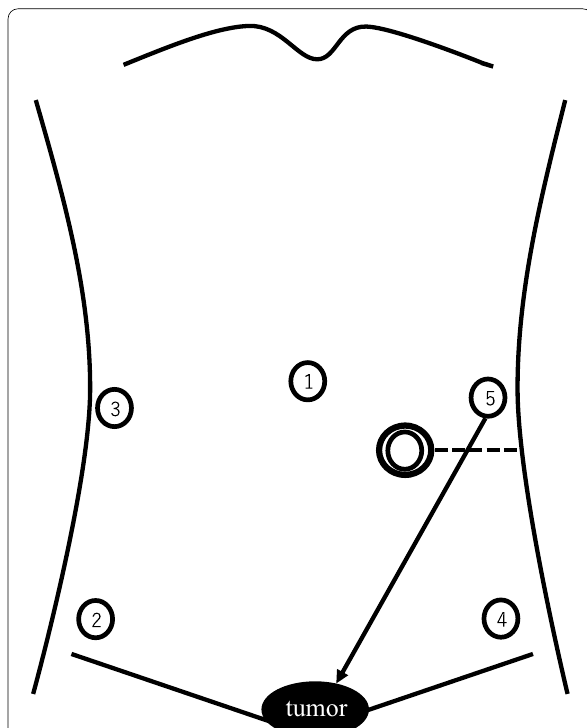
Fig. 7 Suturing of the lifted sigmoid colon to the lateral abdominal wall could prevent the movement of the assistant’s forceps from the fifth trocar during the next operation. The dotted line, a black arrow and numbers point to the sigmoid mesentery, direction of forceps and order of port insertion,